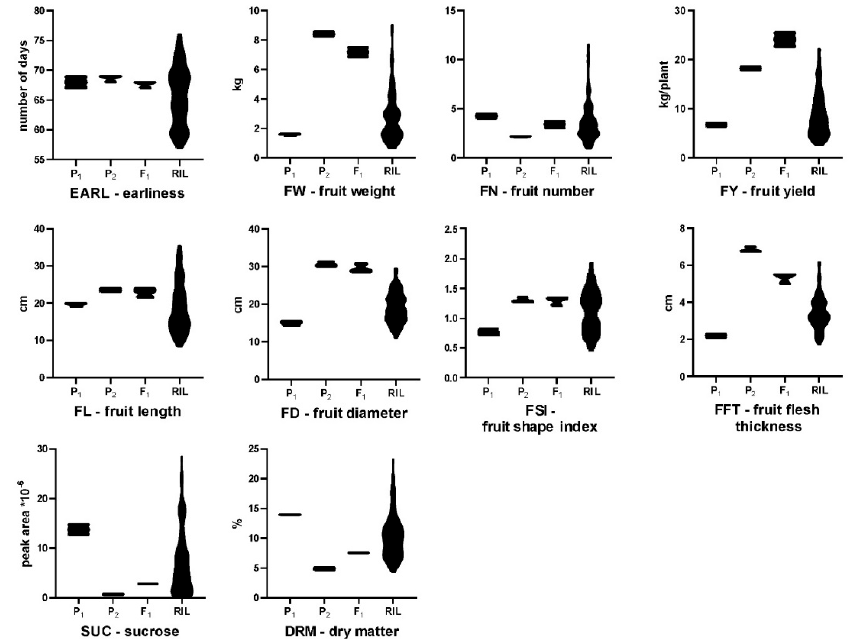
Figure 2. Violin plots representing the distributions of fruit-associated quantitative trait values in parental lines P 1 and P 2 , and F 1 and F 6 RILs. The data for experiment II are presented.